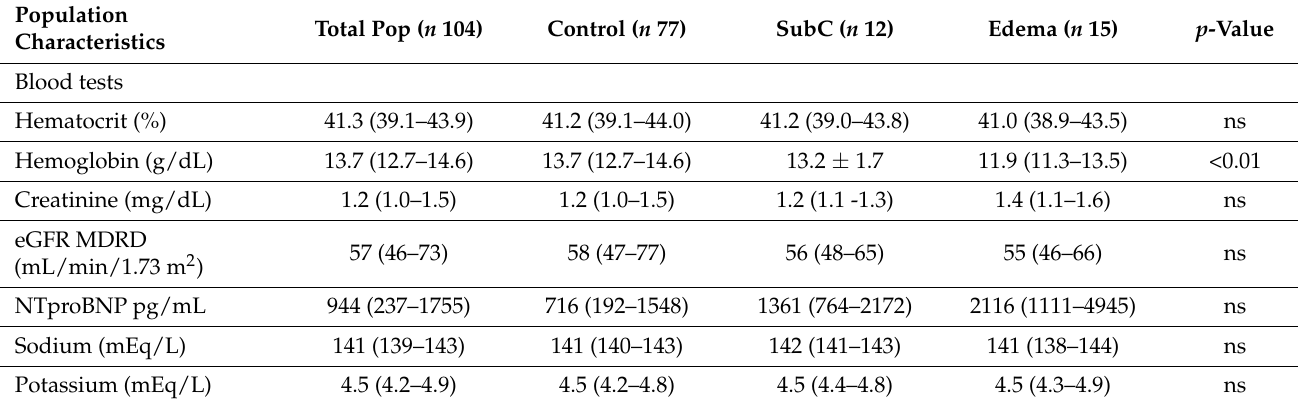
Table 2. Blood sample results divided into subgroups under comparison. Group “Control”: patients without clinical signs of peripheral congestion nor echographic signs of congestion. Group “SubC” (Sub Clinical congestion): patients with echographic signs of congestion without peripheral clinical congestion. Group “Edema”: patients with peripheral congestion irrespective of echographic